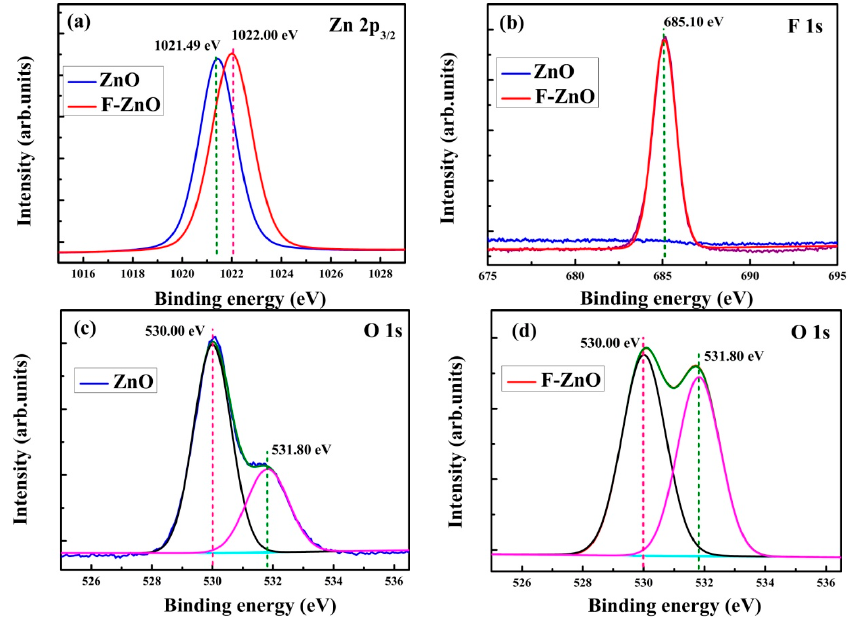
Figure 3. The X-ray photoelectron spectroscopy (XPS) measurement of the surface of ZnO films and with SF 6 plasma treatment: ( a ) Zn 2p3 / 2, ( b ) F 1s, and ( c ) and ( d ) O without and with SF 6 plasma treatment: ( a ) Zn 2p3/2, ( b ) F 1s, and ( c ) and ( d ) O 1s.